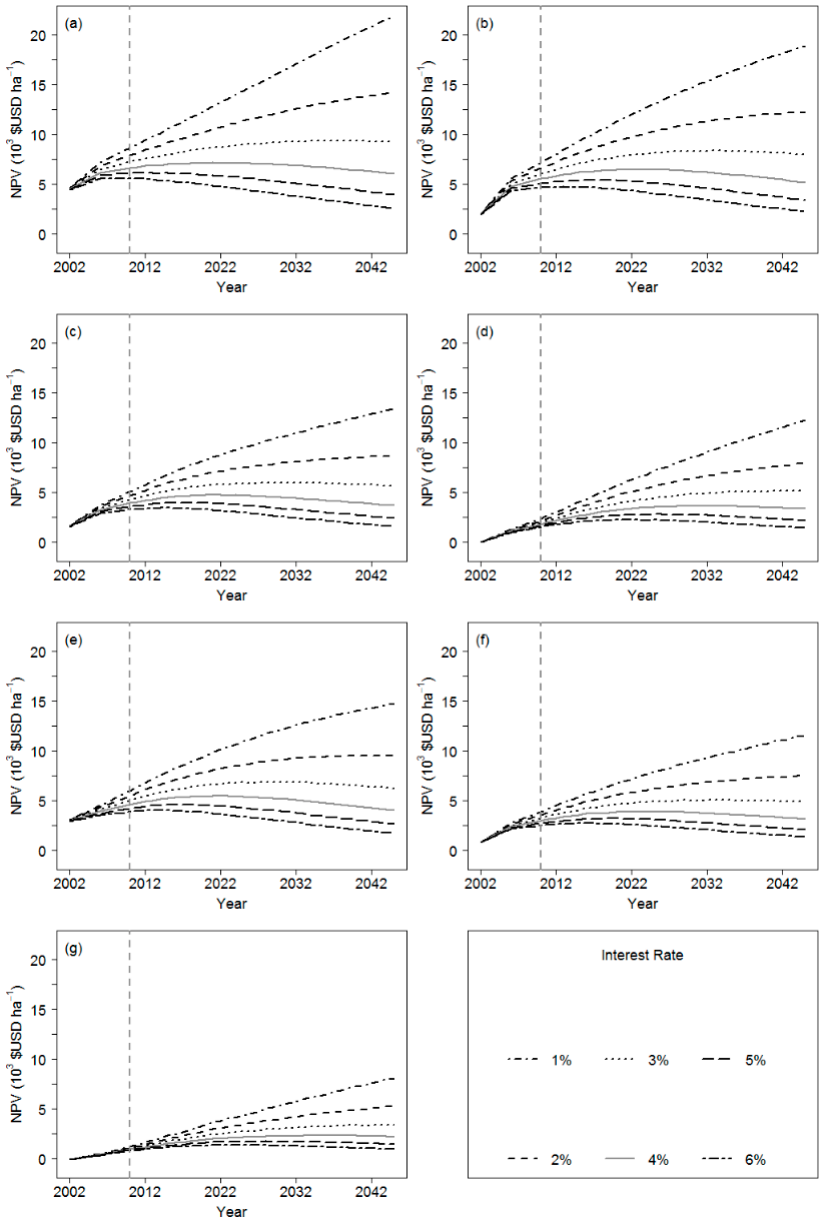
Figure 6. Net present value (NPV; USD$ ha − 1 ) for six treatments and control using six different interest rates. Treatments: ( a ) Control; ( b ) light low thinning (Low33); ( c ) light crown thinning (Crown33); ( d ) light dominant thinning (Dom33); ( e ) heavy low thinning (Low50); ( f ) heavy crown thinning (Crown50); ( g ) heavy dominant thinning (Dom50). The vertical dashed line marks the split between observed data to the left and projected data to the right.